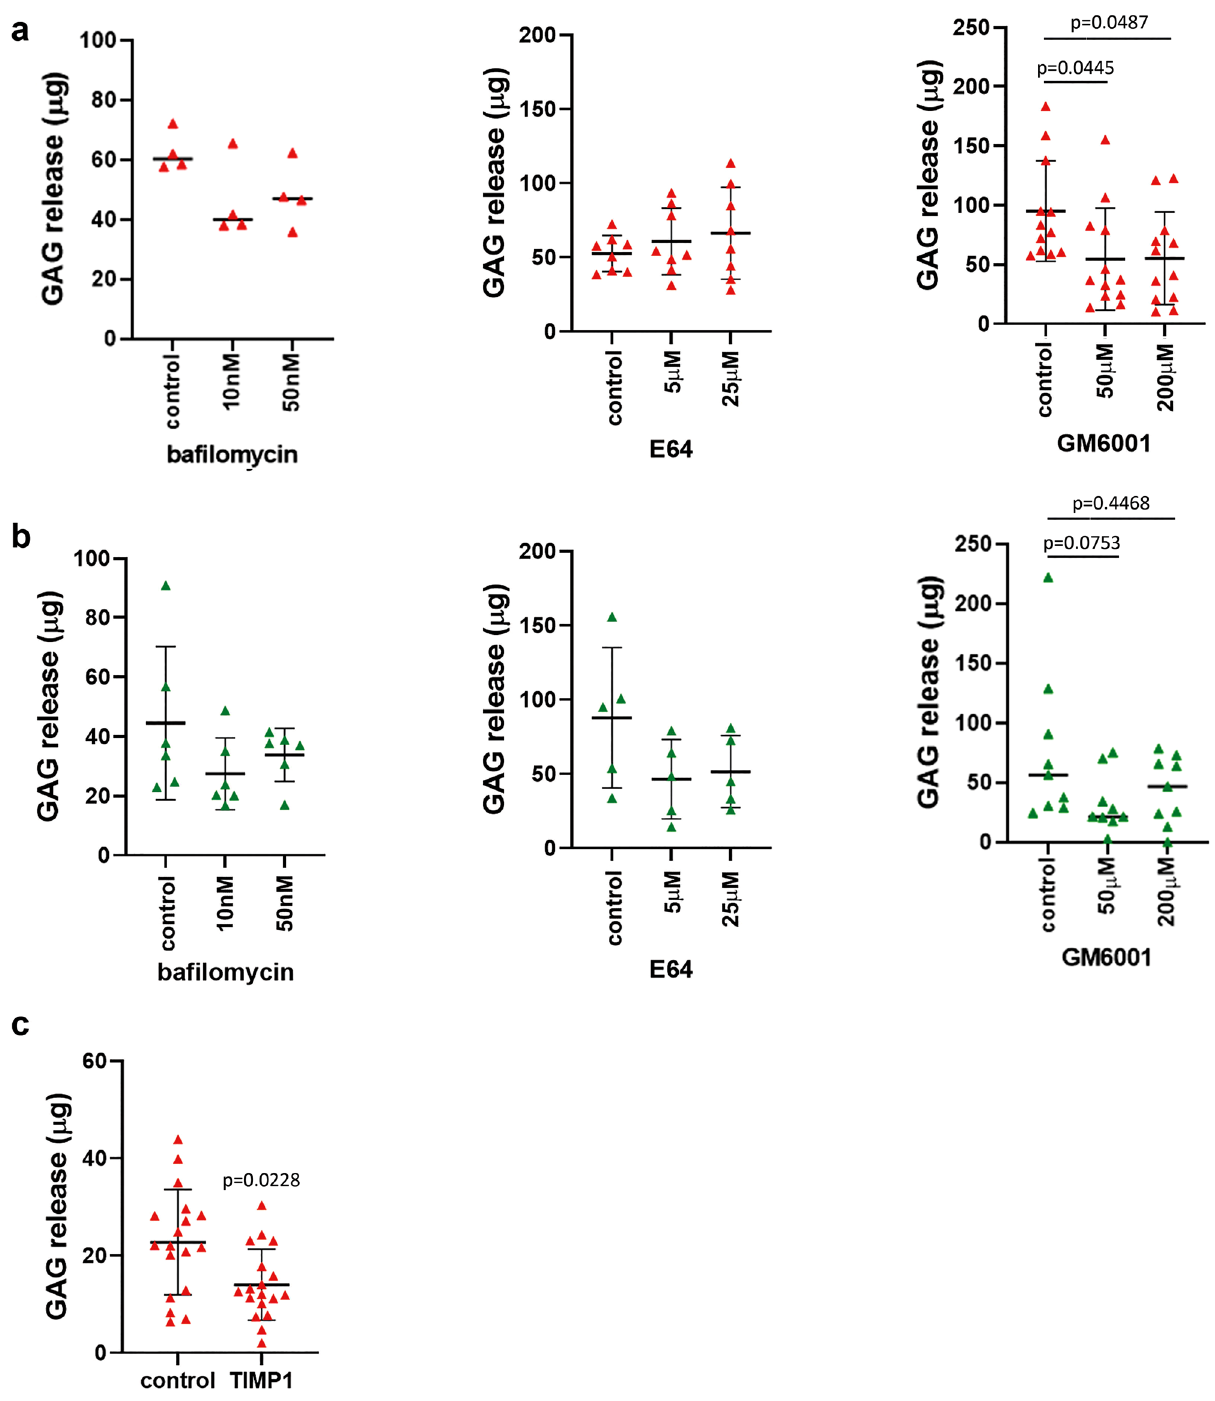
Figure 3. MMPs drive osteoclast-mediated cartilage degradation. ( a , b ) Effect of bafilomycin, E64 and GM6001 on osteoclast-mediated release of GAG from ( a ) acellular or ( b ) cellular cartilage after 13 days of differentiation. N varies for each graph, as represented by the number of data points. Statistics: ( a ): bafilomyin, Kruskal–Wallis ANOVA; E64 and GM6001, one-way ANOVA. ( b ) bafilomycin and E64, one-way ANOVA; GM6001, Kruskal– Wallis ANOVA. ( c ) Effect of recombinant human TIMP1 (100 nM) on GAG release from osteoclasts cultured on acellular cartilage (n = 18; T